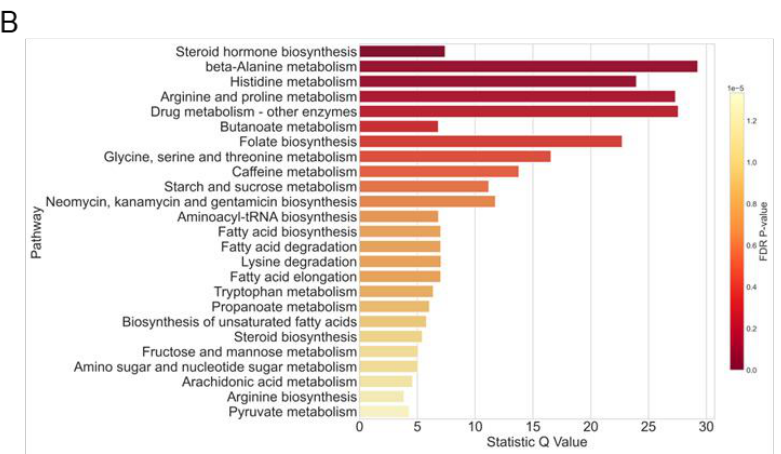
Figure 6. Differentiated metabolites in CRC samples. ( A ) Volcano plot of significantly changed metabolites in CRC. |Log2(foldchange)| > 0.25, p value < 0.05. Orange dots: significantly accumulated metabolites; blue dots: significantly depleted metabolites; gray dots: non-significant; black circles: reported biomarkers of CRC from literature. ( B ) Pathway enrichment analysis from significantly changed metabolites by comparing CRC and healthy control groups. Visualization was based on MetaboAnalyst 5.0 (https://www.metaboanalyst.ca/ (accessed on 11 September2022)). Appropriate classification methods are critical in predictive analysis to uncover links between potential biomarkers, complex phenotypes, and clinical data. In this study, three tree-based algorithms, namely, AdaBoost, random forest (RF), and XGBoost, were se- lected for classification. Their performance was evaluated via an F1 score based on a 10- times repeated trial for each [40]. Compared to the other two methods, XGBoost produced the tightest cluster with the highest (> 0.95) F1 scores for both HCtrl and CRC classes, which suggests that XGBoost is potentially useful for the classification of different groups of metabolomics samples (Figure 7).